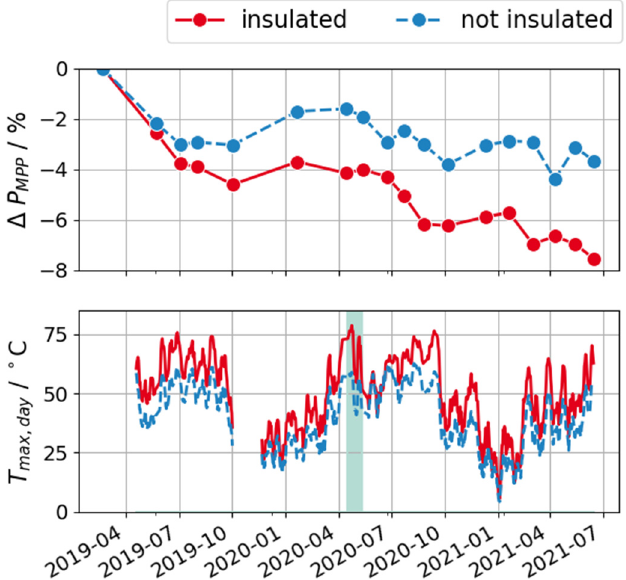
multi-crystalline PERC modules during two years of outdoor exposure (top). Weekly average of the daily maximum module temperature (bottom). The green colored background highlights a time period with open circuit